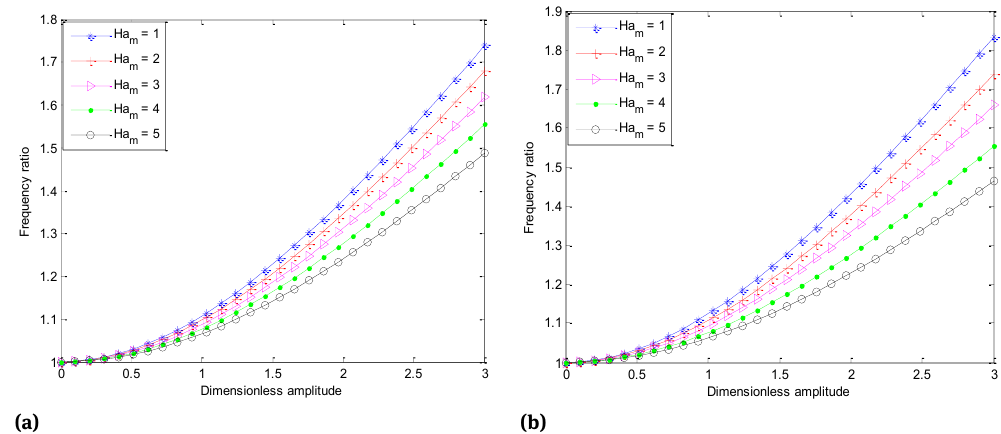
Figure 12: (a) Effects of magnetic force parameter on the frequency ratio for simply supported nanobeam (b) Effects of magnetic force parameter on the frequency ratio for clamped-clamped